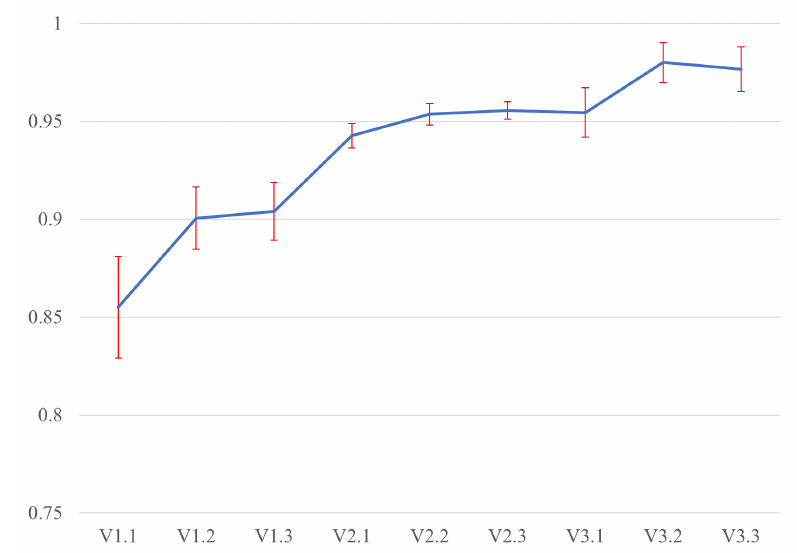
Figure 4. Comparison chart of the performance of